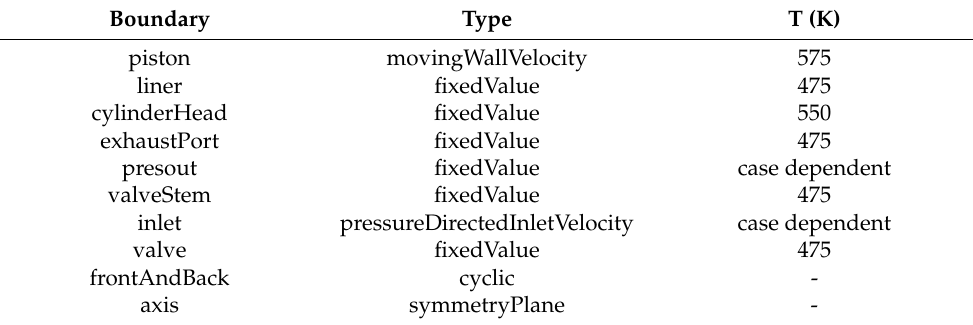
Figure 4. Influence of mesh density (number of cells) on the total fresh air concentration (fresh air mass [kg]/total mass [kg]) in the cylinder. Table 2. Boundaries specifications for the simulation.